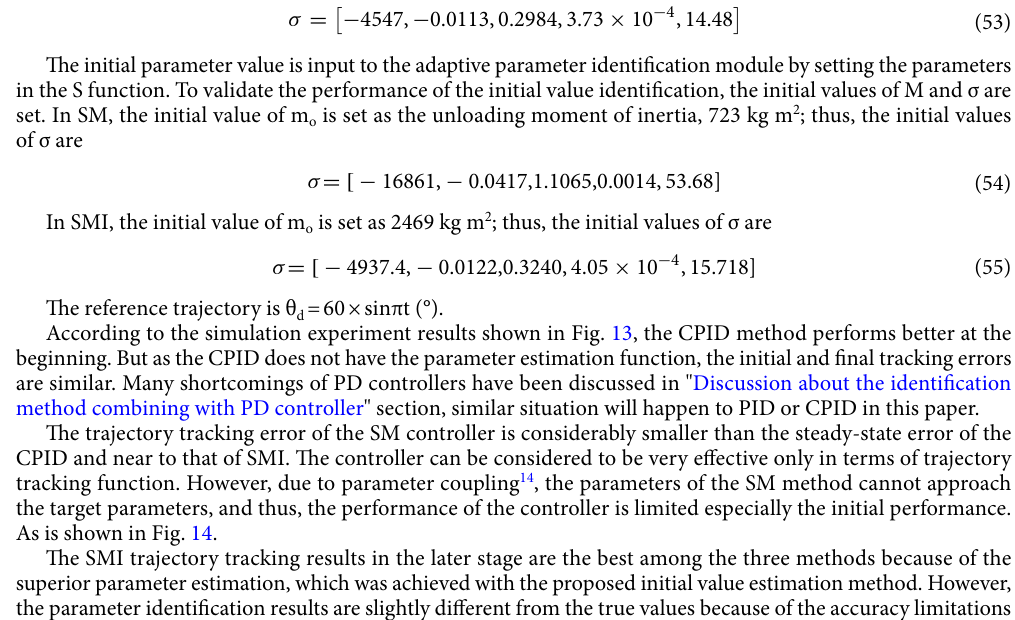
Table 1. In the simulation program, the real value of m o is 2681 kg m 2 , and the calculated values of the parameters are.